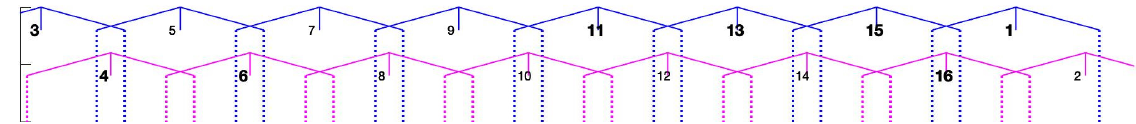
Figure 3. Marking of angular ranges in which pinion teeth are in contact with gear teeth